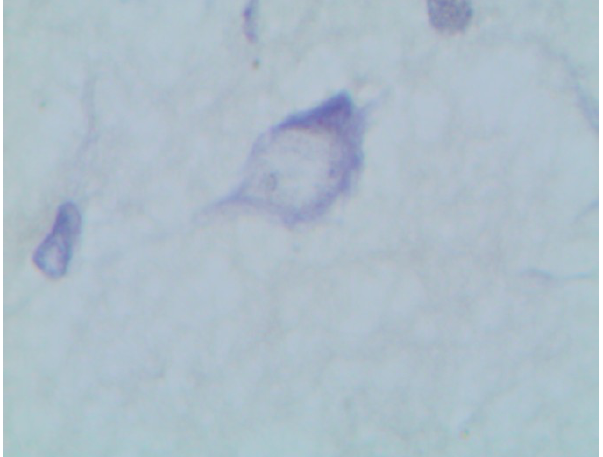
Figure 10. The brain of a control rat, the nucleus caudatus area (Nissl stain, magnification ×900). A typical neuron with evenly spread tygroid in the soma and the axon hillock.